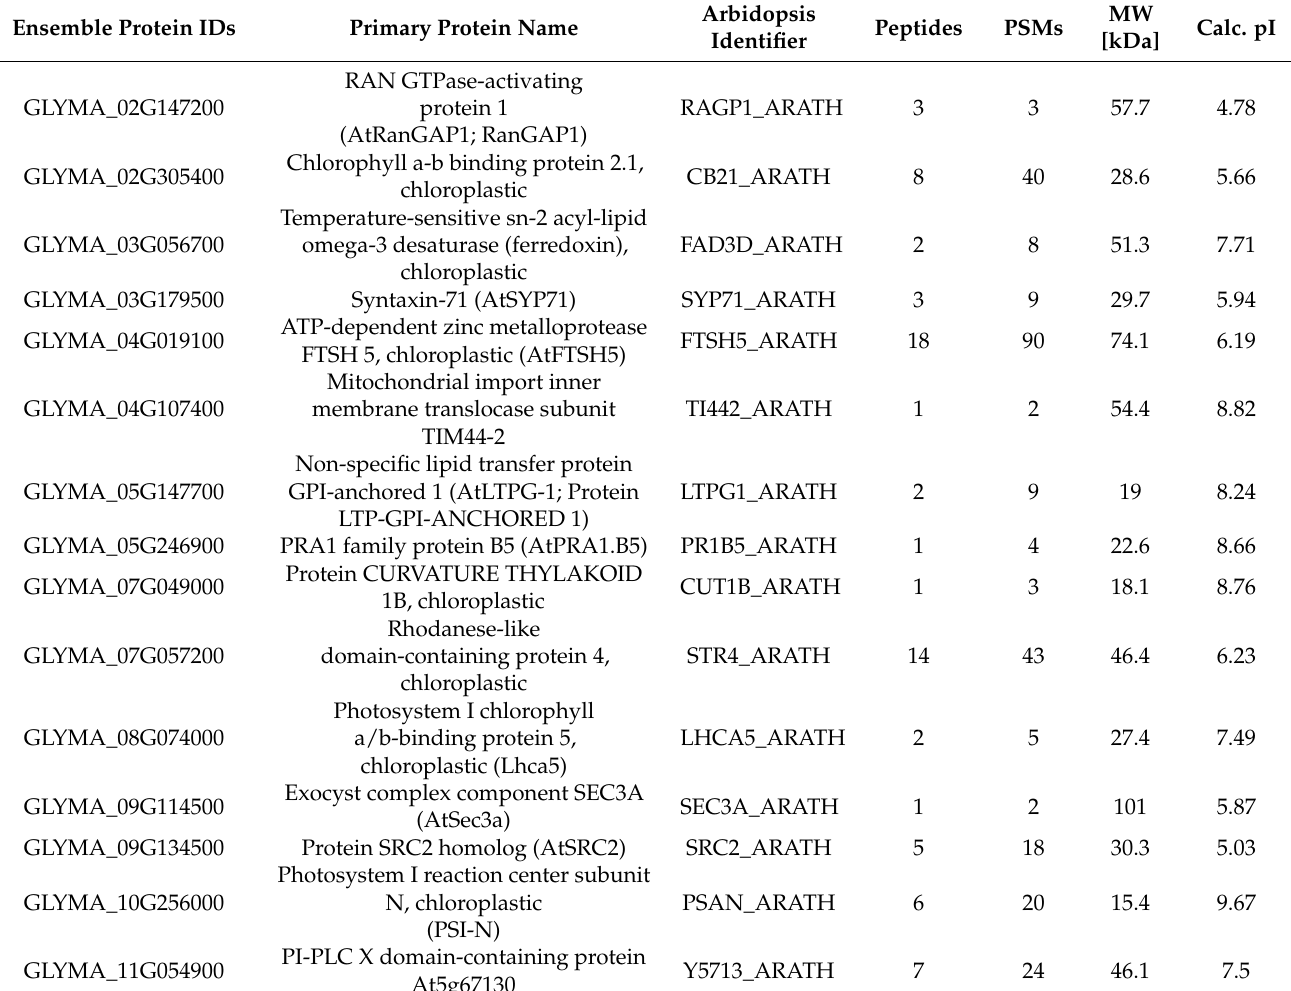
Table 2. Down-regulated membrane proteins under salt stress in soybean